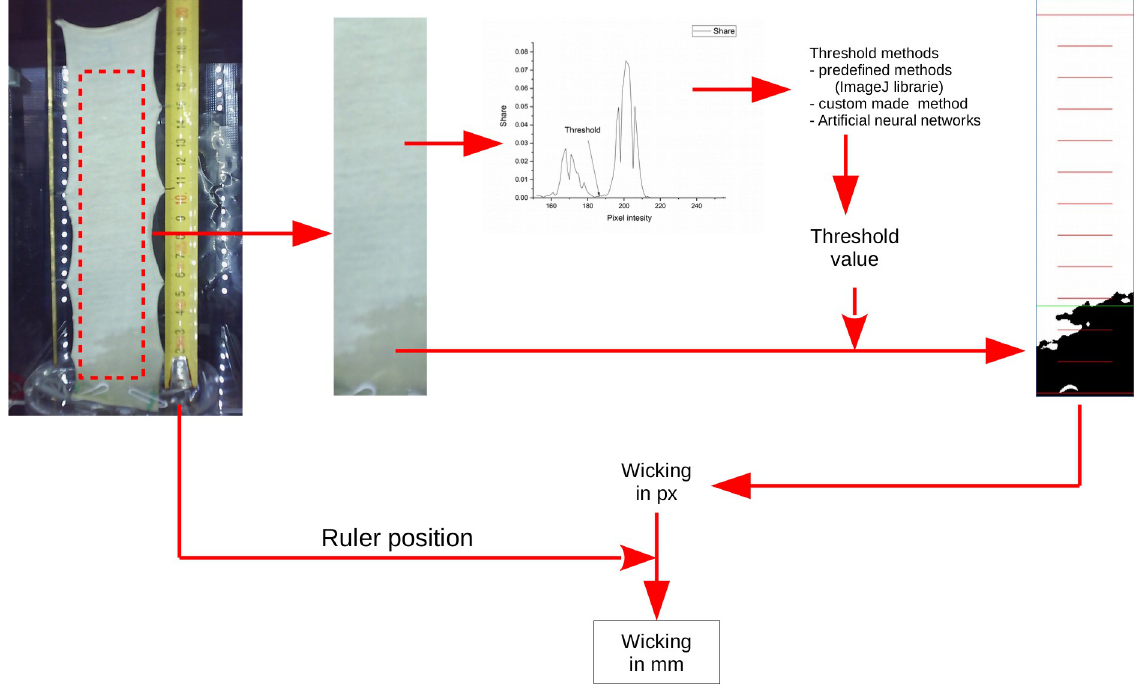
Fig 4. Principe of determination of